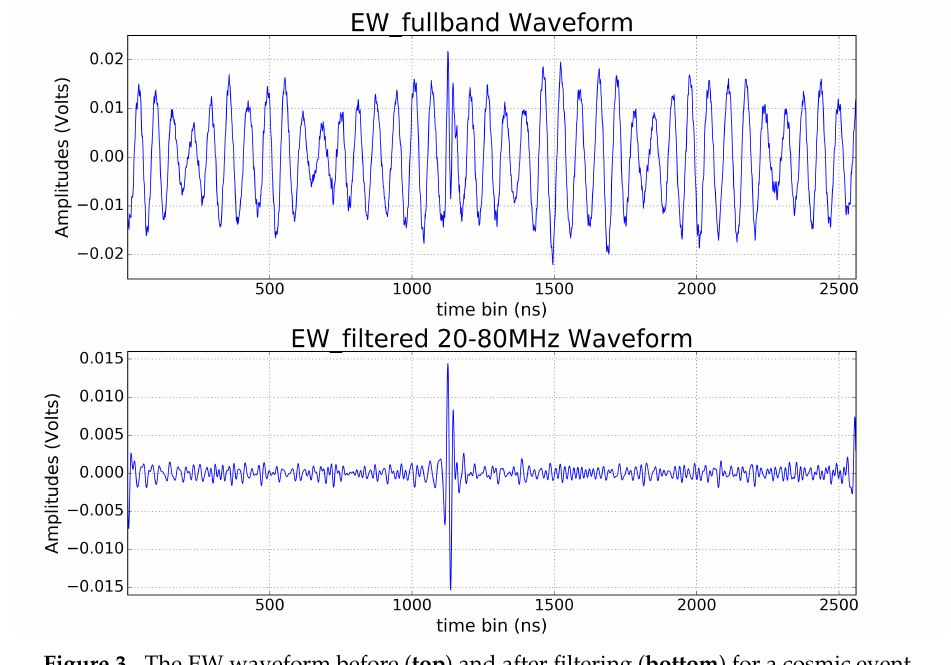
Figure 3. The EW waveform before ( top ) and after filtering ( bottom ) for a cosmic event.